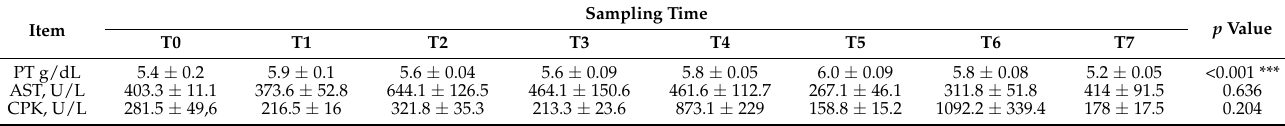
Table 3. Biochemical parameters of trotter horses in relation to the training